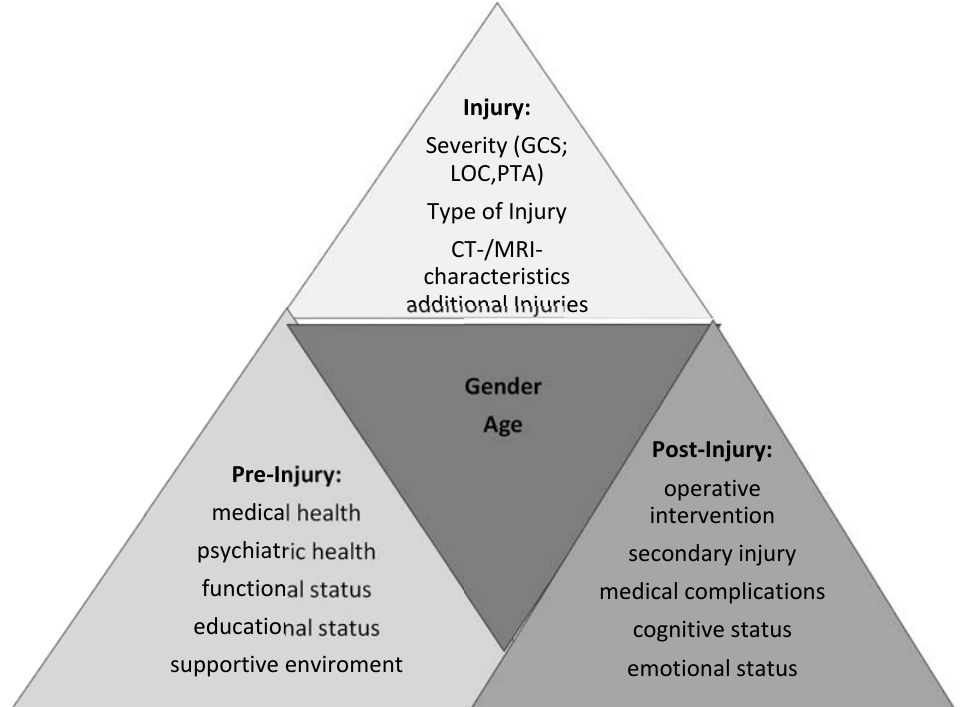
Figure 1. Interactivity between age and gender with pre-, post- and injury